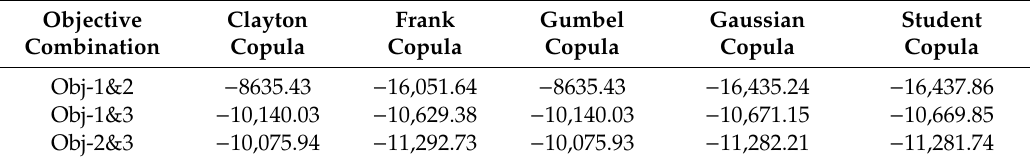
Table 2. Five copula functions’ Akaike Information Criterion (AIC) evaluating